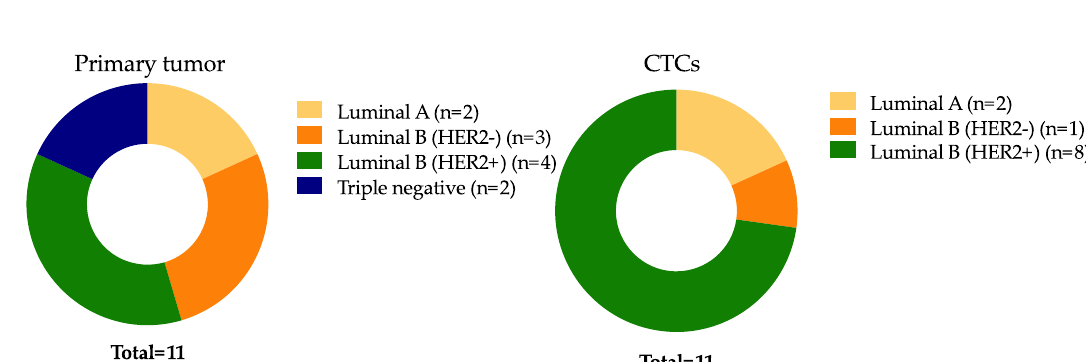
Figure 4. Molecular subtypes of primary tumors and CTCs in untreated (I) breast cancer patients and treated by NAC